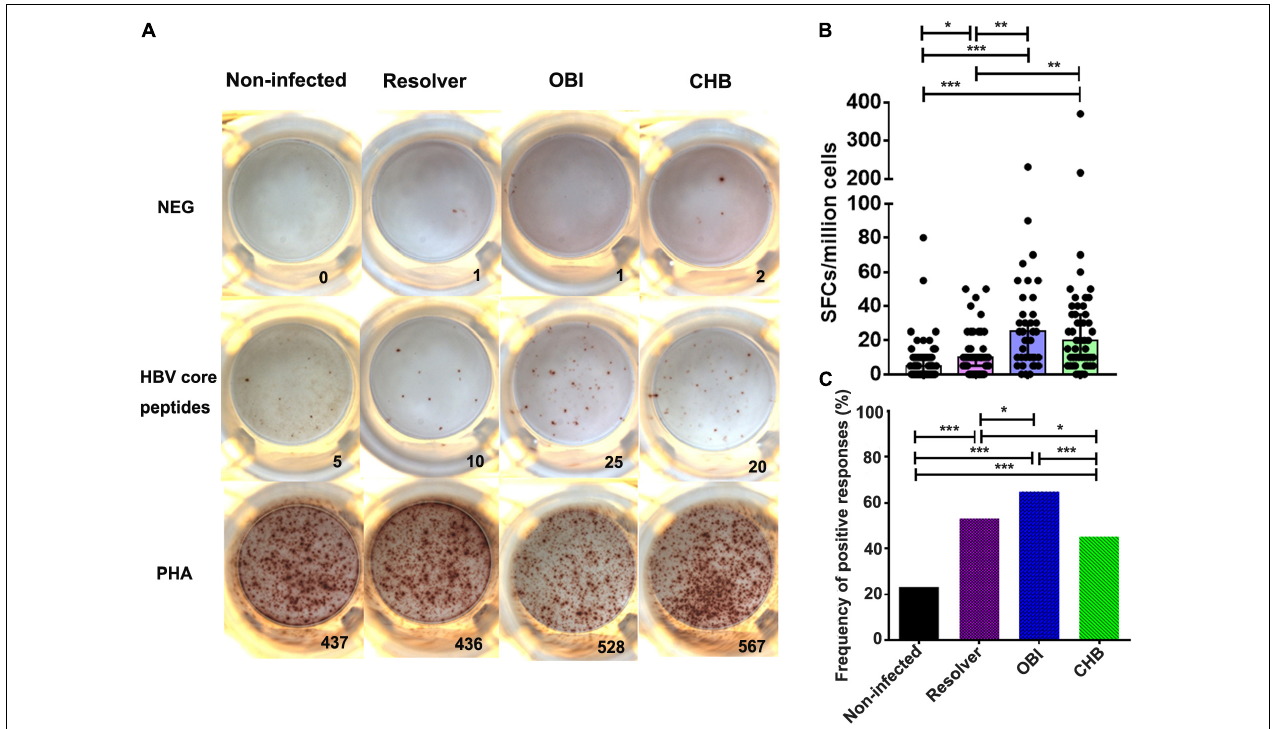
FIGURE 2 | A specific IFN- γ secreting T-cell response of PBMCs to HBV core peptides between four groups of blood donors with different status of HBV infection by ELISpot. (A) Representative specific IFN- γ secreting T-cell response of PBMCs by ELISpot after stimulation with HBV core peptides. (B) The level of IFN- γ secreting T-cell response from individual donors is presented as a mean number of spot-forming cells per 1 × 10 6 PBMCs in triplicates. Each dot represents a value over the cut-off from individual donors and the median is indicated for each group. (C) Comparison of the frequency of positive response obtained in the four groups. P -values are analyzed by one-way ANOVA and two-tailed t -test. Statistically significant differences are shown with asterisks (* P < 0.05, ** P < 0.01, and *** P <